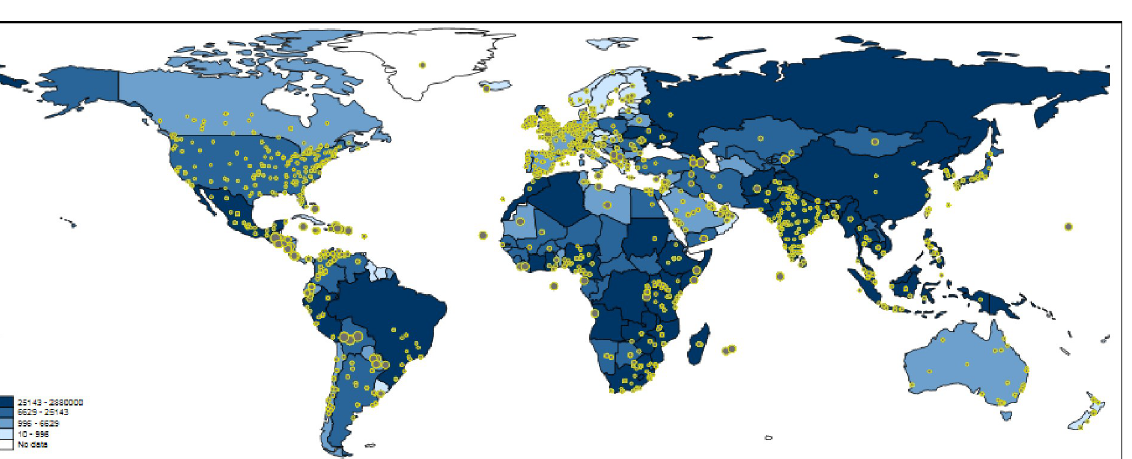
Fig 2. Twitter user classification for tweets on papers dealing with tuberculosis, malaria, and HIV. The graphs are restricted to the set of profiles each with geographical location that could be converted into geo-coordinates (see section 3.1.3).